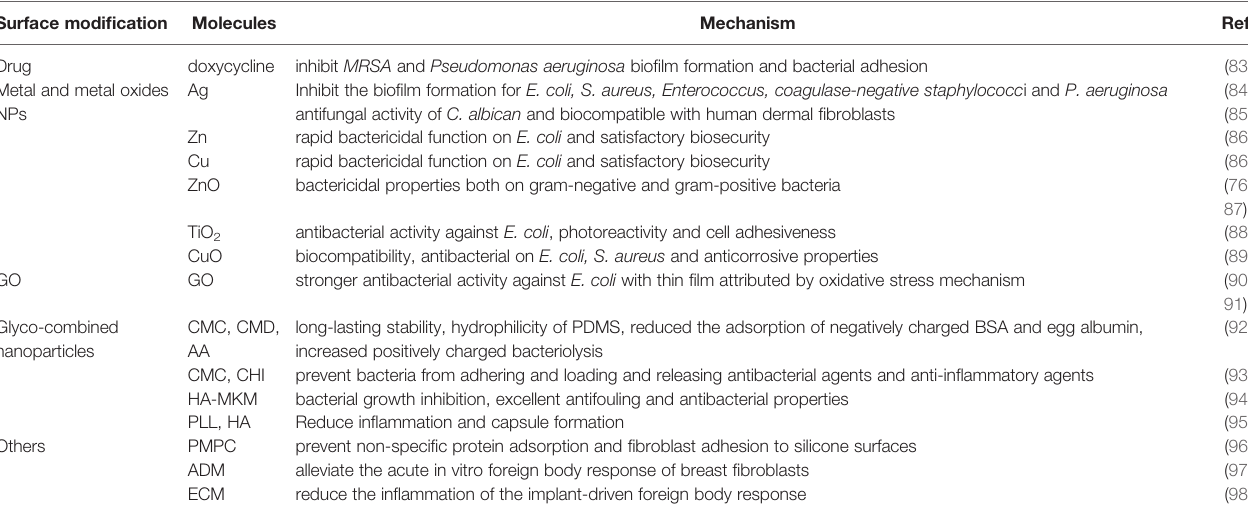
TABLE 2 | Various strategies of silicone surface modi fi cation. Surface modi fi cation Molecules